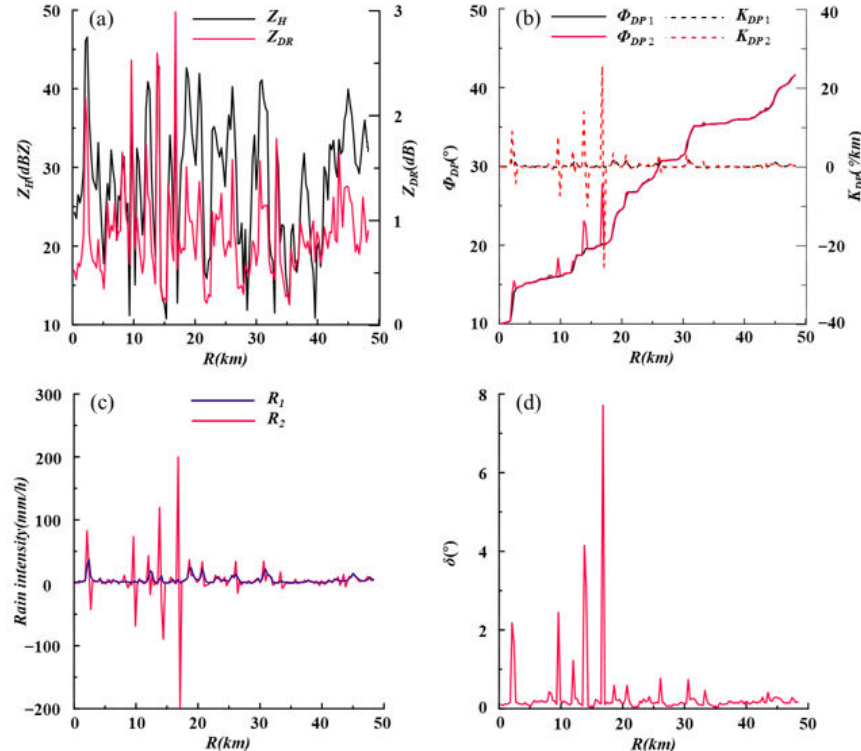
Figure 3. Simulated ( a ) Z H and Z DR curves with distance using DSD measurements from 12:12 to 15:58 on 10 June 2019, ( b ) Φ DP and K DP calculated from DSD with δ effects (red curve) and without δ effects (black curve), ( c ) Rain intensity calculated by K DP without δ effects (R 1 , blue curve) and with δ effects (R 2 , red curve), and ( d ) Backscatter differential phase.